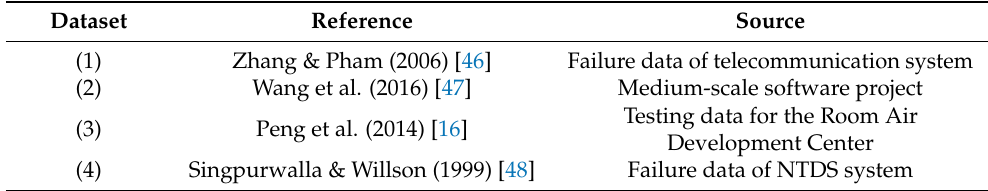
Table 2. The source of the open datasets.